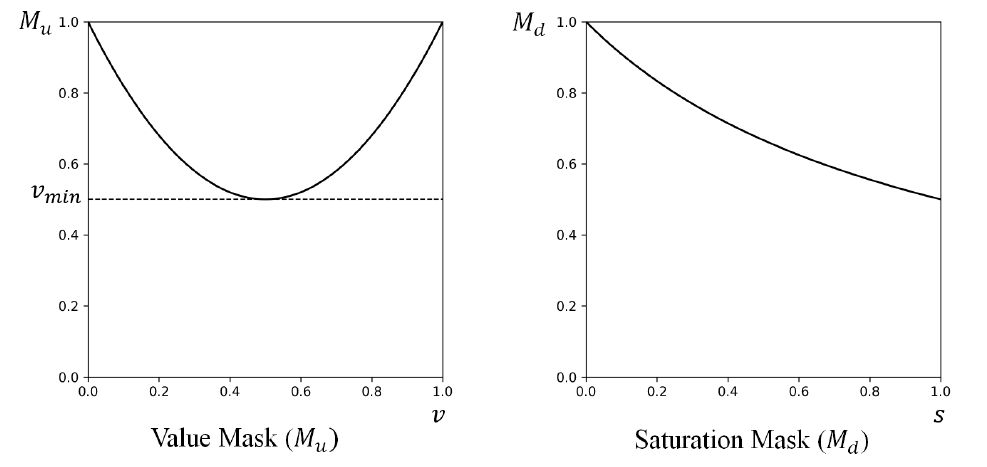
Figure 8. ( left ) Value mask, M u . ( right ) Saturation mask, M d .